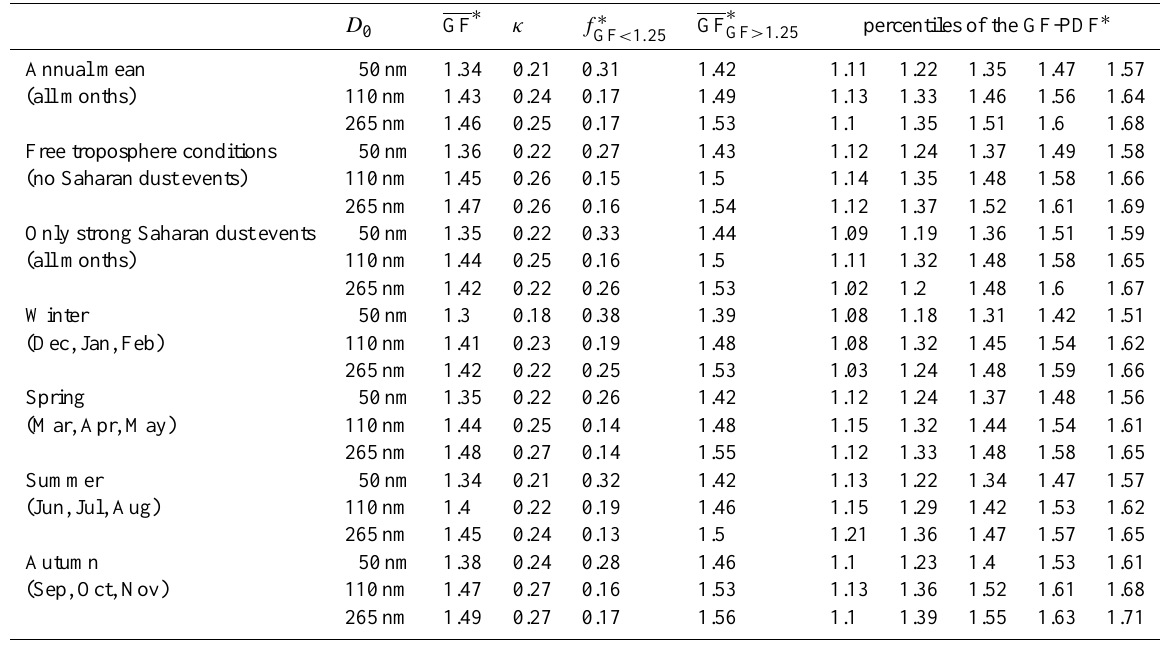
Table 2. Mean values for dry diameters ( D 0 ) of 50, 110, 265nm of the mean hygroscopic growth factor (GF) at 90% RH, of the hygro- scopicity parameter κ , of the number fraction of the GF-PDF < 1.25 ( f GF < 1 . 25 ), of the GF of all more hygroscopic particles with GF > 1.25 (GF GF > 1 . 25 ), and 10th, 25th, 50th, 75th, and 90th GF percentile of the mean GF-PDF. Data are reported for the complete 13-month data set, for strong Saharan dust events, for free troposphere conditions (2a.m.–8a.m. UTC=CET-1h), and for the seasons winter, spring, summer, and autumn.